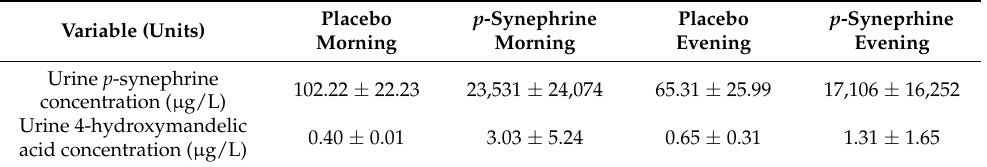
Table 3. Urine p -synephrine and 4-hydroxymandelic acid concentrations after the ingestion of 3 mg/kg of p -synephrine or a placebo in the morning (8:00-10:00 h) or the evening (17:00-19:00 h) in